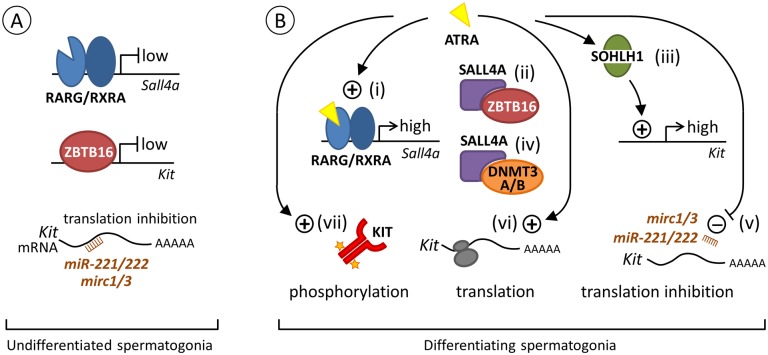
Proposed model for the regulation of Kit expression by ATRA during the transition from Aal to A1 spermatogonia.(A) Spermatogonia at an undifferentiated state. ATRA is not available to activate RARG/RXRA heterodimer and transcription of Sall4 is low. Transcription of Kit is also low because ZBTB16 is bound to its promoter [48]. In addition, translation of Kit mRNA already present in cells [2,49,50] is prevented by the Mirc1, Mirc3 and miR221/222 small interfering RNAs (brown comb) [50,51]. (B) Spermatogonia at a differentiating state upon ATRA action. (i) At the Aal-A1 transition, one possible way for ATRA (yellow triangle) to regulate Kit expression is to activate RARG/RXRA heterodimer, which increases Sall4a expression (high, our study). (ii) SALL4A in large amount can then sequesters ZBTB16 [14], clearing Kit promoter and relieving the repression of Kit transcription normally exerted by ZBTB16 [48]. (iii) ATRA is also proposed to increase the level of SOHLH1, which can replace ZBTB16 on regulatory regions to increase Kit expression (high) [52]. Sohlh1 is however not a direct target of RARG as RAR-binding sites are not found in this gene [34] and its expression is not induced by BMS961 (our study). (iv) Alternatively, SALL4A can also interact with DNMT3A/B to facilitate the epigenetic shift required for A1 differentiation [42,43]. (v) In parallel, ATRA can further induce KIT protein through decreasing expression of microRNA such as Mirc1, Mirc3 and miR221/222 that prevent Kit mRNA translation. How ATRA regulate miRNA expression is however unknown, as RARE have not been identified in the vicinity of their promoters [34,50,51]. ATRA can also function as a rapid, non-genomic, agent by (vi) increasing the loading of Kit mRNA on polysomes (grey ovals) and its translation [41] and (vii) inducing phosphorylation of KIT (orange stars) and of downstream KIT-effectors, reinforcing commitment towards the A1 spermatogonia fate [53].